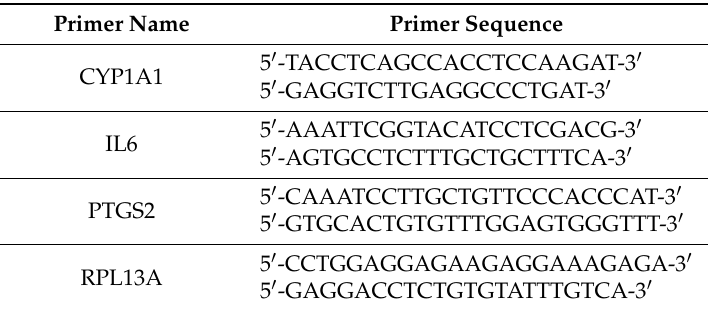
Table 1. Primers for real-time